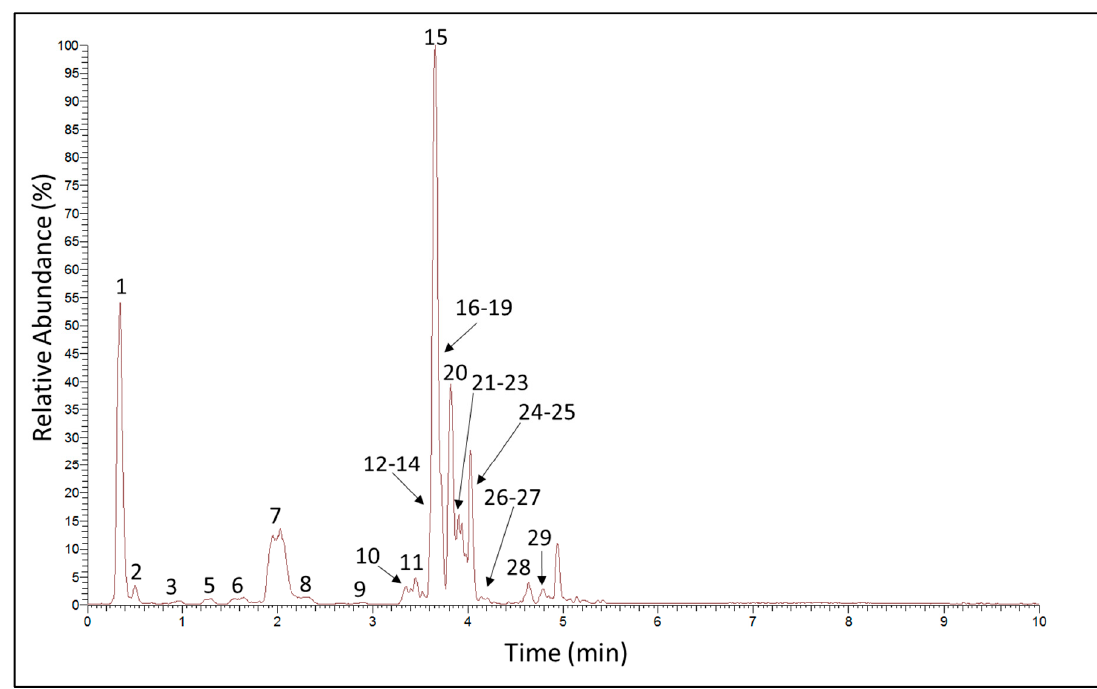
Figure 1. Negative base peak trace from ultra-high performance liquid chromatography–high- resolution mass spectrometry (UHPLC-HRMS) analysis of Hancornia speciosa ethanolic leaf extract.